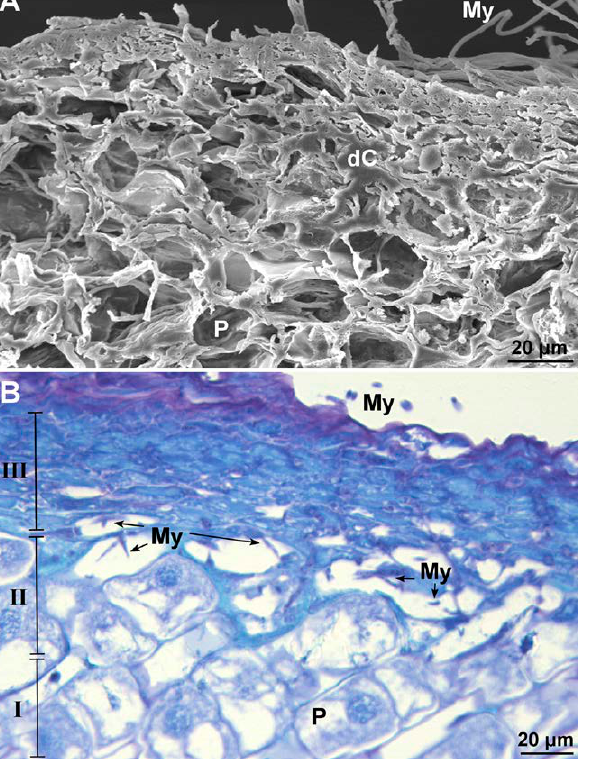
Figure 4. Histopathological effects of Fusarium proliferatum on infected clove tissues. A and B, Detail of the first root cells layers 72 h post inoculation. My: mycelium, dC: dead cells, P: parenchy- ma. A, Scanning electron micrograph. B, Light micrograph after TB